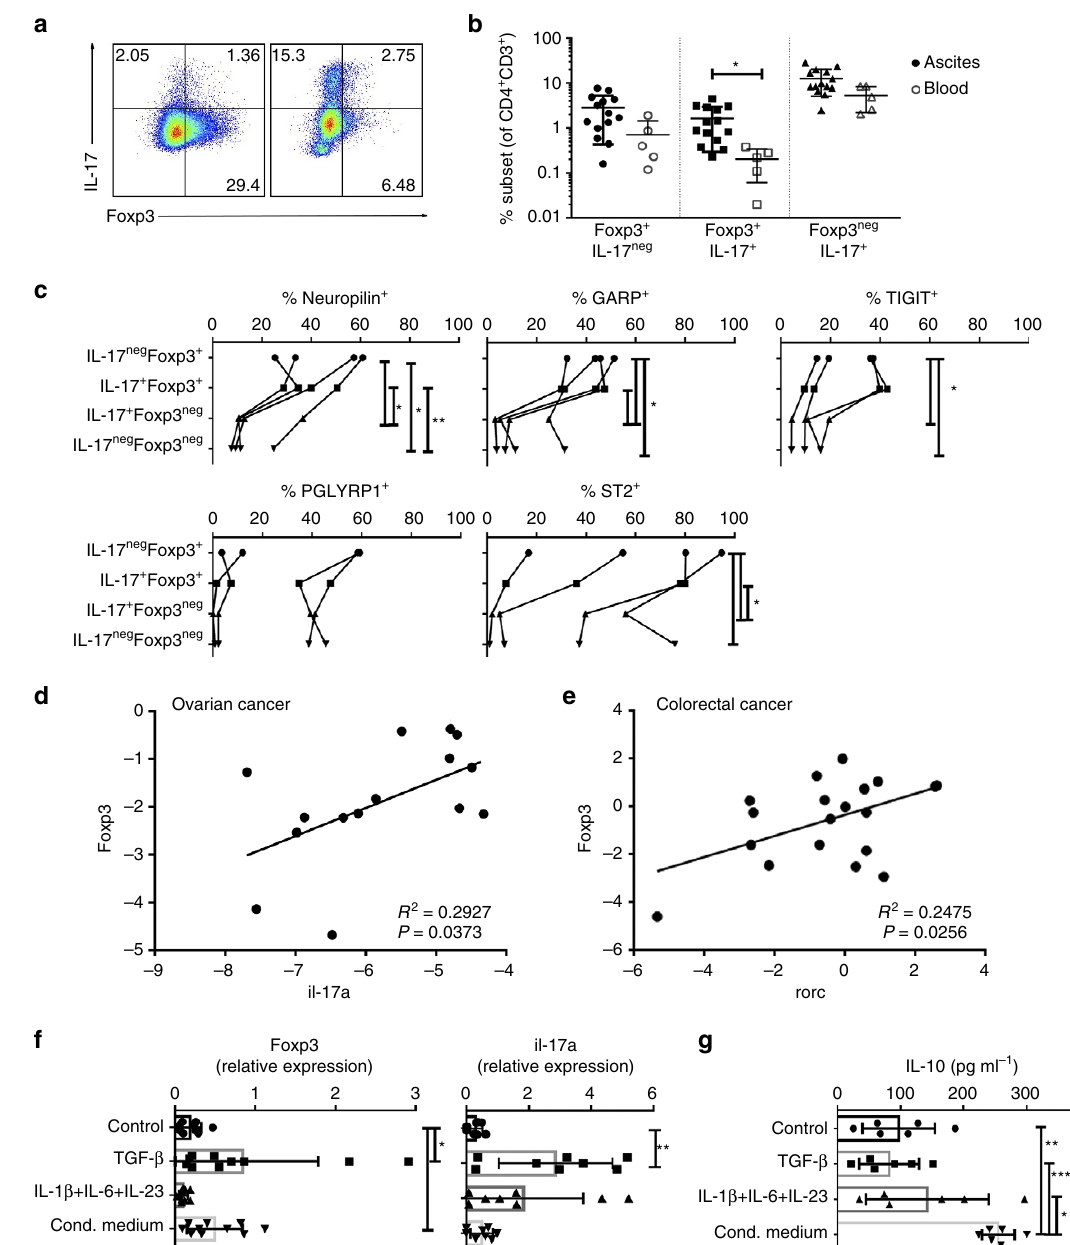
Figure 7 | Tumour induction of T reg -associated characteristics in human Th17 TALs. ( a – c ) Foxp3-expressing IL-17A þ / (cid:2) cells from ovarian cancer patients are also characterized by expression of Th17–T reg cell plasticity-related targets. ( a , b ) Representative intracellular staining of IL-17A and Foxp3 in TALs (CD3 þ CD4 þ -gated) from two ovarian cancer ascites—note the inclination towards either Foxp3-expressing (left) or IL-17-producing (right) phenotype ( a ) and a comparison of the percentages of individual subsets ( b ) in TALs from ovarian cancer ascites ( n ¼ 15 ) compared with the lymphocytes from peripheral blood of the matched donors ( n ¼ 5). The fluorescence-activated cell sorting (FACS) gating strategy of live CD4 þ Tcells is presented in Supplementary Fig. 8f. ( c ) Flow cytometric analysis of neuropilin, GARP, TIGIT, PGLYRP1 and ST2 expression in human ovarian cancer Th17–T reg CD4 þ TAL subsets ( n ¼ 4, refer to Table 1a for the details on patient data). All data are mean ± s.d. * P o 0.05 and ** P o 0.01 by paired t- test. ( d ) Linear regression of Il17a and Foxp3 expression in ovarian cancer TALs ( n ¼ 15, refer to Table 1b for the details on patient data). R 2 ¼ 0.2927, P ¼ 0.0373. ( e ) Linear regression of Rorc and Foxp3 expression in colorectal cancer tissue ( n ¼ 20, refer to Table 1c for the details on patient data). R 2 ¼ 0.2475, P ¼ 0.0256. ( f , g ) Tumour- associated microenvironment induces Foxp3 expression and IL-10 production in human IL-17-producing CD4 þ cells. Expression of Foxp3 ( n ¼ 10) and Il17a ( n ¼ 8) and IL-10 production ( n ¼ 6) by IL-17A-producing CD4 þ cells cultured in control, Th17- or T reg -driving (TGF- b , ovarian cancer conditioned medium) conditions for 6 days. All data are mean ± s.d. * P o 0.05, ** P o 0.01 and *** P o 0.001 by one-way analysis of variance